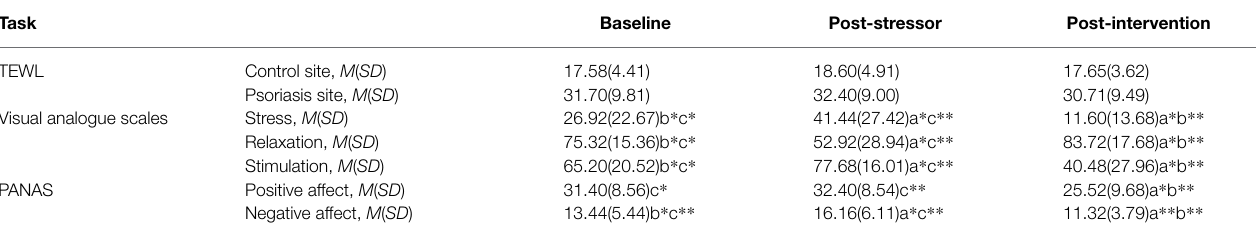
TABLE 2 | Summary statistics and post-hoc comparisons for the outcomes across time, irrespective of condition.